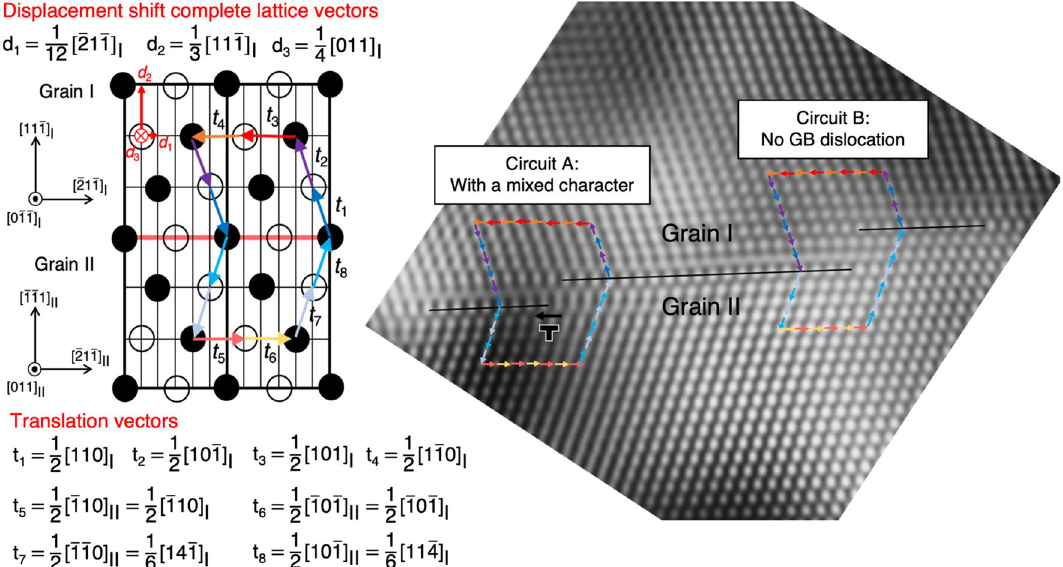
Figure 7. Two closed Burgers circuits labeled by “A” and “B” used to analyze the disconnections imaged in Fig. 4b. The Burgers vector in the circuit A was identified to have a mixed character, while the Burgers vector of dislocation in the circuit B was not identified. The disconnection in the circuit B could be free of dislocation, or there were two partial dislocations having opposite signs. The corresponding lattice vectors are schematically illustrated and described with a proper coordinate matrix transformation, as labeled from t 1 to t 8 . The corresponding displacement shift complete (DSC) lattice vectors are also specified to be d 1 = 1/12 [ 211 ] I , d 2 = 1/3[11 1 ] I , and d 3 = 1/4[011] I